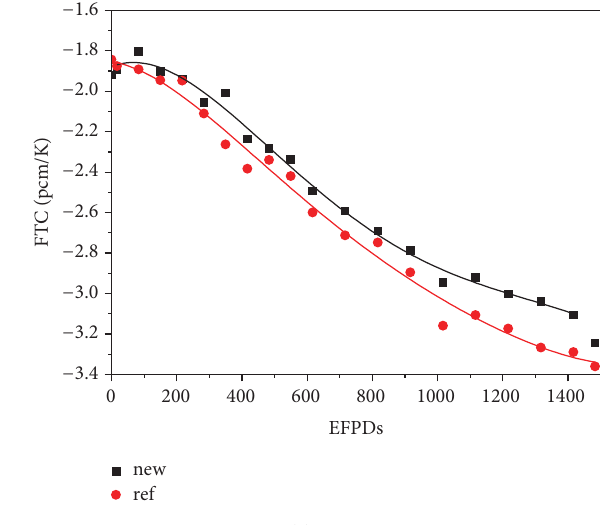
Figure 10: FTC versus